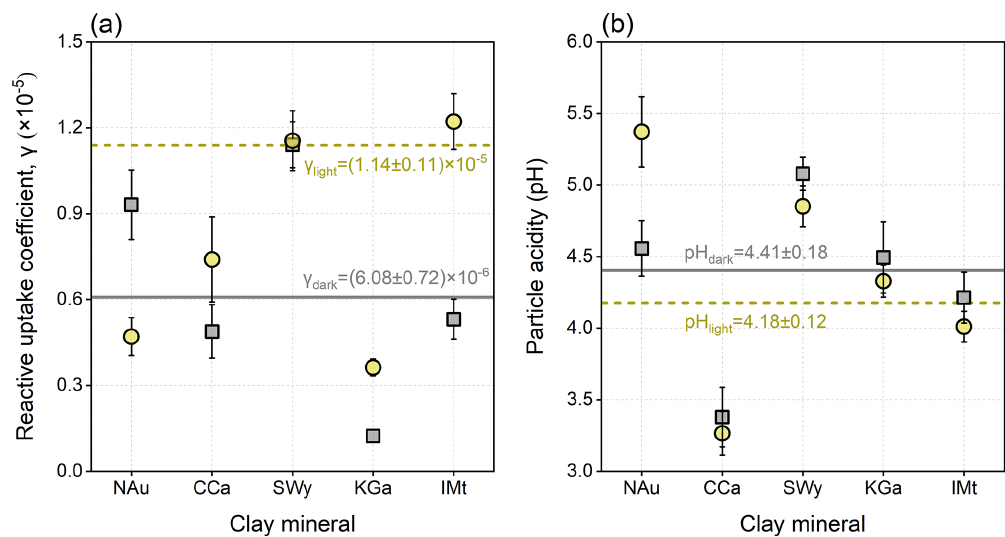
Figure 4. Analysis results of the in situ infrared spectra recorded for the heterogeneous reaction of SO 2 on clay minerals and natural dust. (a) Reactive uptake coefficients ( γ ) for the heterogeneous formation of sulfate. (b) Particle acidity (pH) of the reacted particle samples. The dark (grey square) and light (yellow circle) conditions were both considered. Dots represent the results of clay minerals, and those of natural dust are showed by the lines. All error bars represent